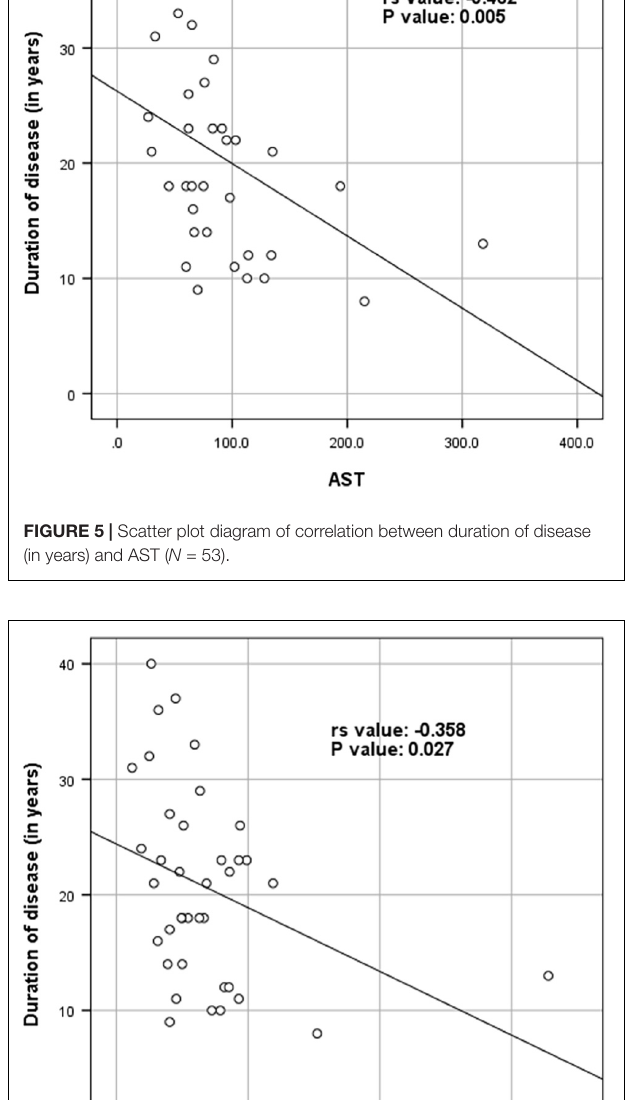
(F10 A) showed abnormal ischemic changes in the ECG.